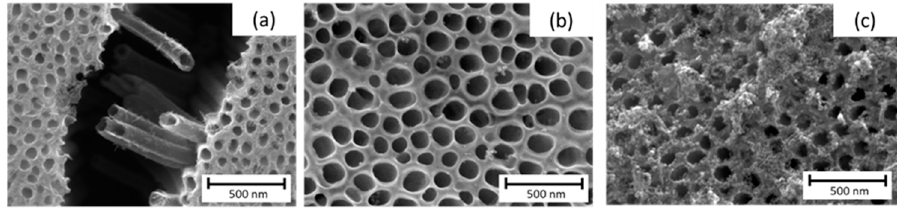
Figure 2. SEM micrographs of the top view of the nt-TiO 2 / α -Fe 2 O 3 formed using ( a ) electrochemical method, ( b ) CVD, ( c ) SILAR method.